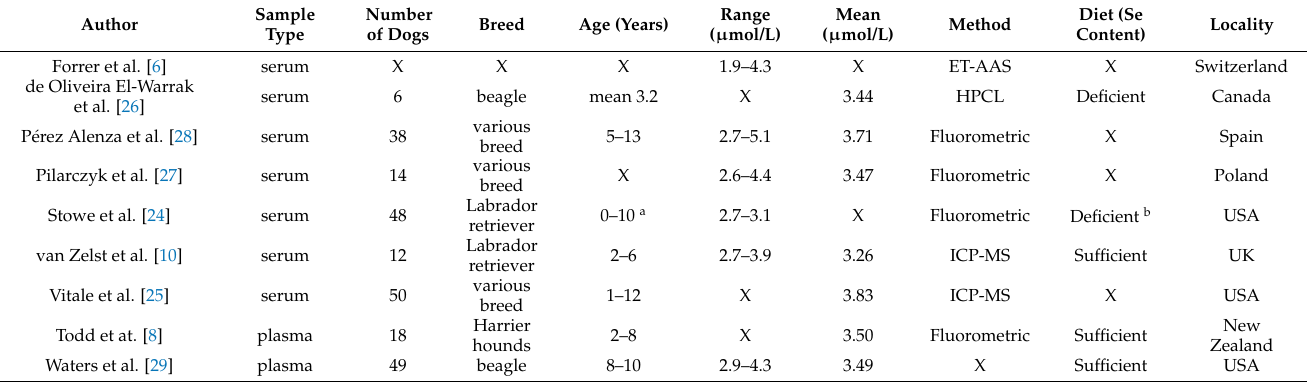
Table 1. Levels of selenium in serum and plasma measured by particular authors in their